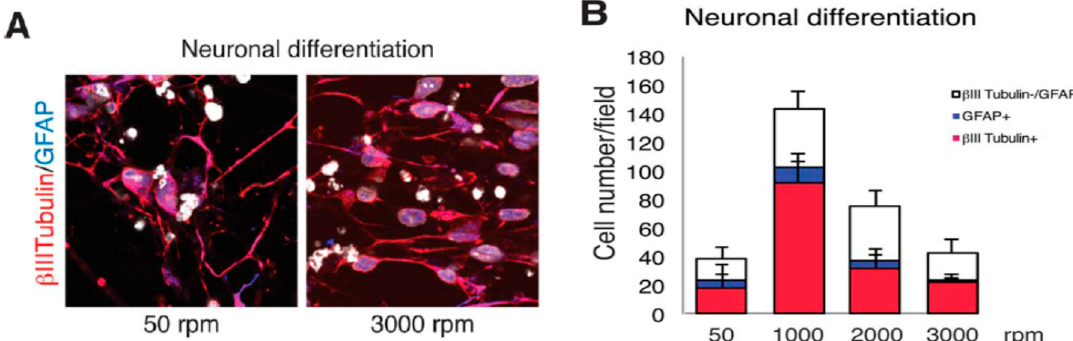
Figure 29. ( A ) Immunofluorescent staining for β 3-tubulin (red) and GFAP (blue), and ( B ) mean percentage of cells expressing β 3-tubulin and GFAP upon NSCs differentiation. n = 3–5. Reproduced with permission from [15], published by Wiley, 2017.